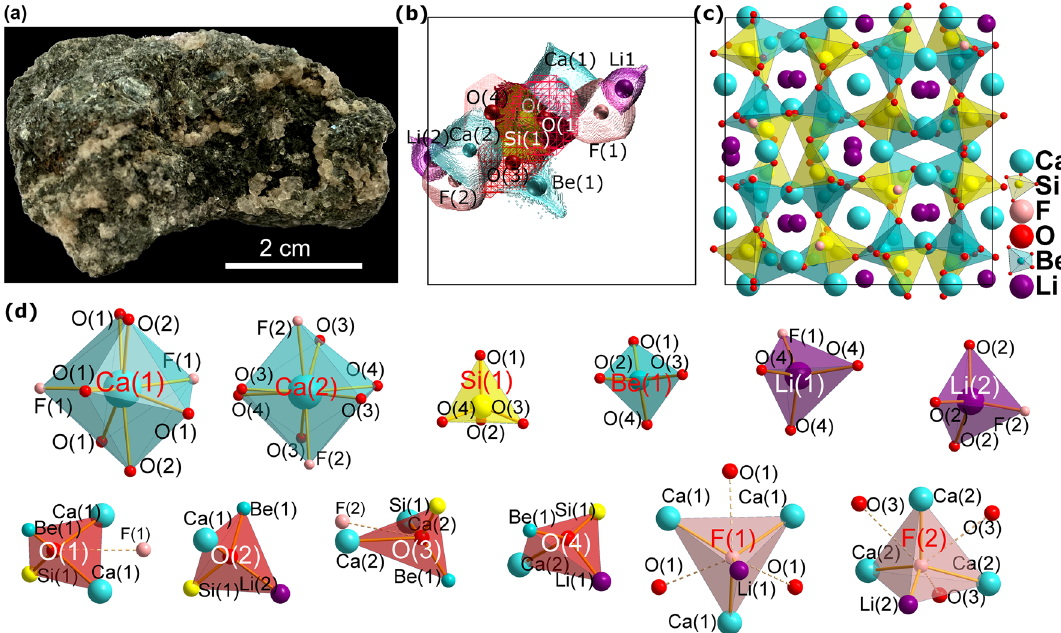
Figure 1. The host rock containing transparent hsianghualite crystals. The mineral forms small, several millimetre in diameter, rounded crystals, sometimes with poorly developed dodecahedral faces or granular and compact aggregates ( a ). The representation of ions (so called ionic basins), bordered by the zero-flux surfaces of electron density ( b ), the polyhedral representation of the crystal structure of His ( c ) and fundamental polyhedra present in the His structure ( d